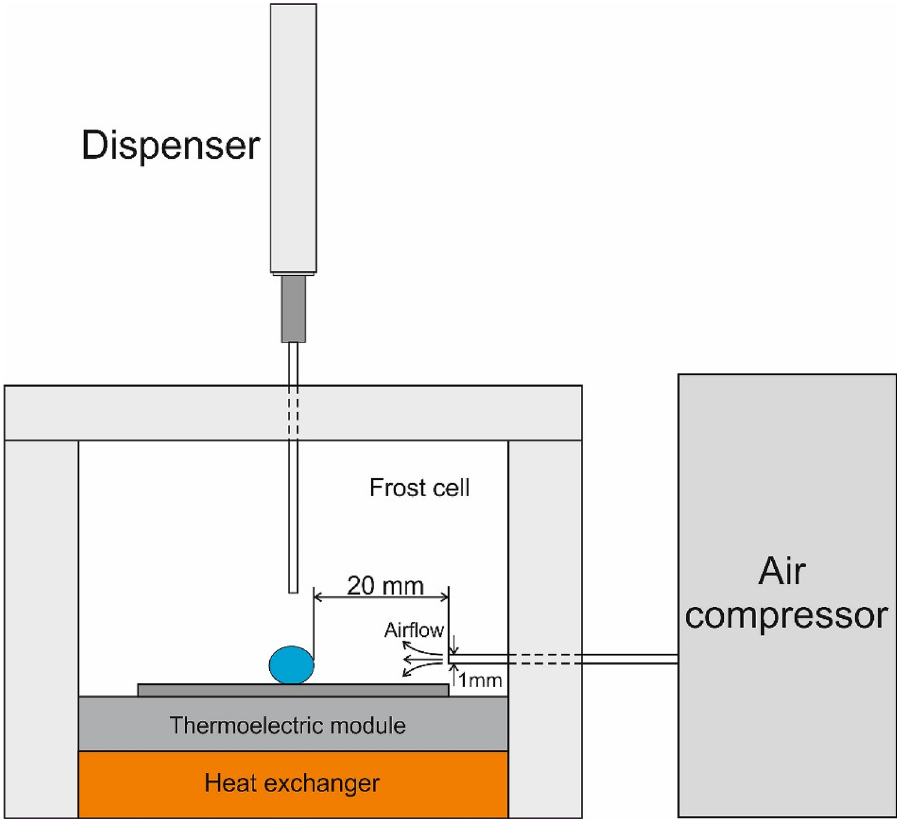
Figure 4. Scheme of the experimental unit used for testing of the anti-icing properties of the reported surfaces is